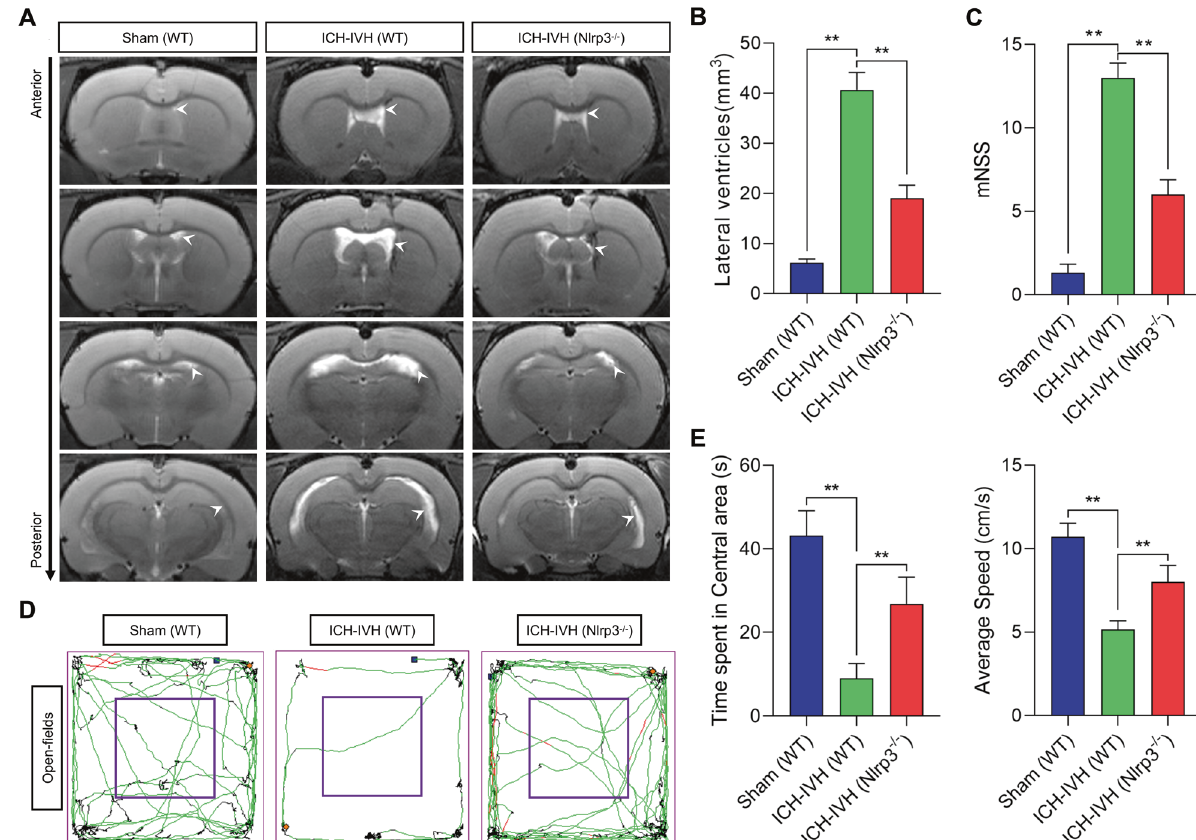
Fig. 1 Evaluation of hydrocephalus and neurological function with or without NLRP3 knockout after ICH-IVH. A T2-weighted images of different groups of rats showed ventricular dilatation, and the white arrows indicate the lateral ventricles. B Trajectories of different groups of rats after ICH-IVH in the open- fi eld experiment. C Statistical results of the central area movement time and mean velocity of different groups throughout the open- fi eld experiment ( n = 6, one-way ANOVA). D Statistical analysis of lateral ventricular volumes of different groups based on MRI images ( n = 3, one-way ANOVA). E The mNSS of different groups ( n = 6, one-way ANOVA). The results are expressed as the mean ± SD, ** P <